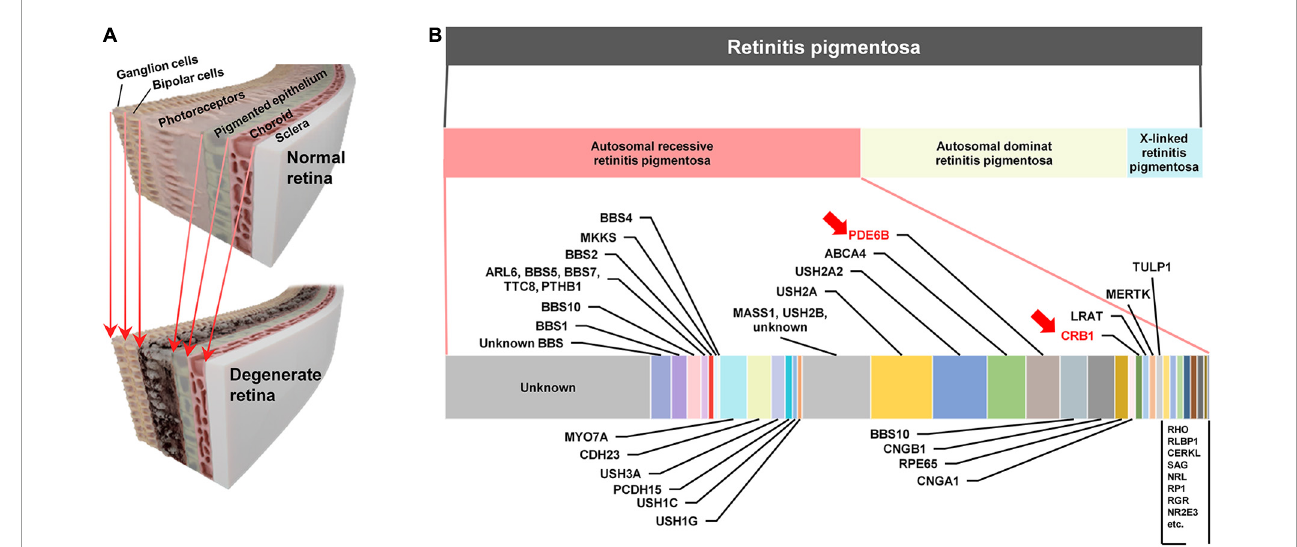
FIGURE1 (A) Schematic illustrations of the healthy retina (top) and the retina damaged by outer retinal degenerative diseases such as retinitis pigmentosa (bottom). As the retina degenerates, the photoreceptors are primarily damaged. (B) Spectrum of retinitis pigmentosa (RP) (second row) RP has three major types autosomal recessive retinitis pigmentosa (ARRP; 50–60%), autosomal dominant retinitis pigmentosa (ADRP; 30–40%), and X-linked RP (5–15%) (last row). Estimated relative contributions of various genes causing ARRP in human patients. The estimated proportions are from a previous work (Hartong et al., 2006). Among the causal genes listed in this horizontal bar chart, PDE6B and CRB1 are marked with red arrows, which are corresponding to murine mutation genes (i.e., Pde6b and Crb1 ) of retinal degeneration ( rd ) 10 and rd8 mouse models, respectively.